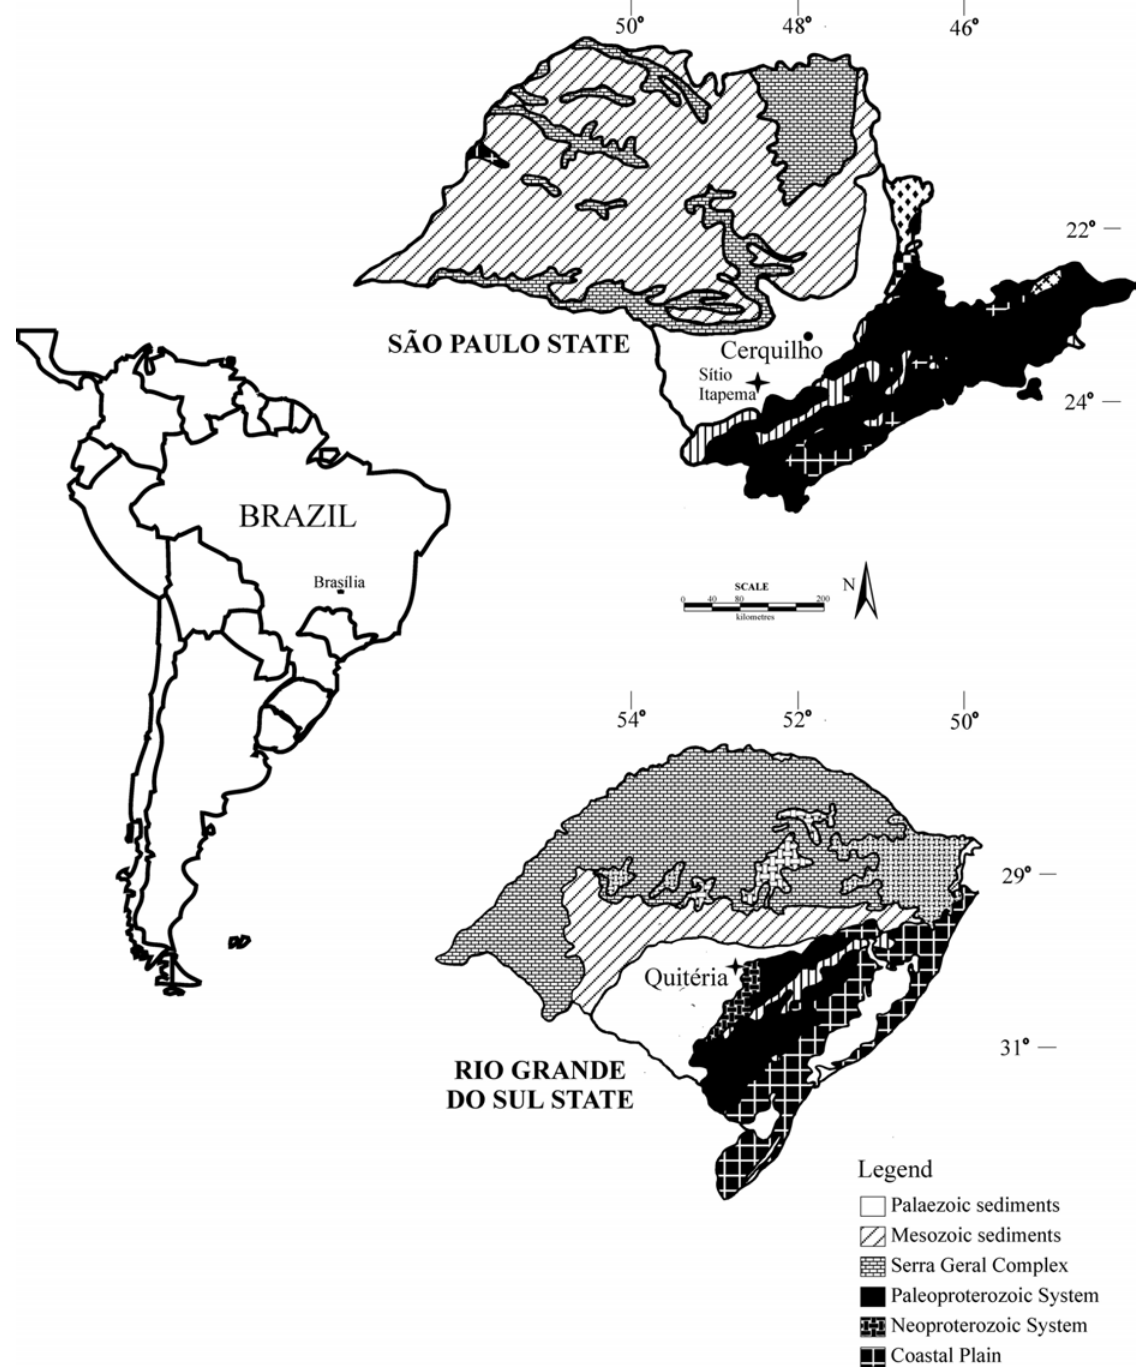
Fig. 1 – Localization of the studied areas: Cerquilho and the Sítio Itapema Outcrop, in the São Paulo State; Quitéria Outcrop, in the Rio Grande do Sul